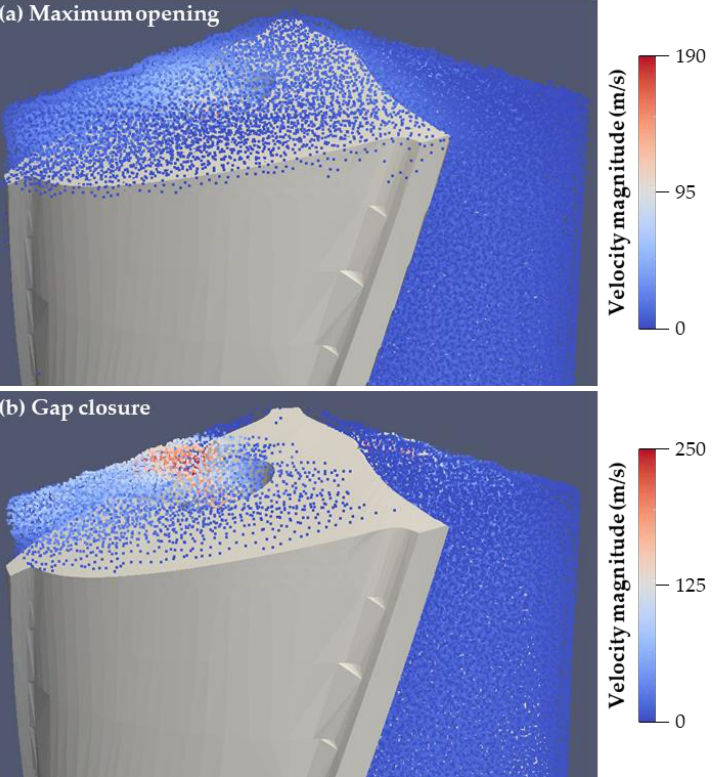
Figure 4. SPH particles colored by velocity magnitude at two different time instants of the simulation: (a) maximum opening of the gap between the drill bit and hole bottom and (b) complete closure of the gap, including the drill bit vibration.